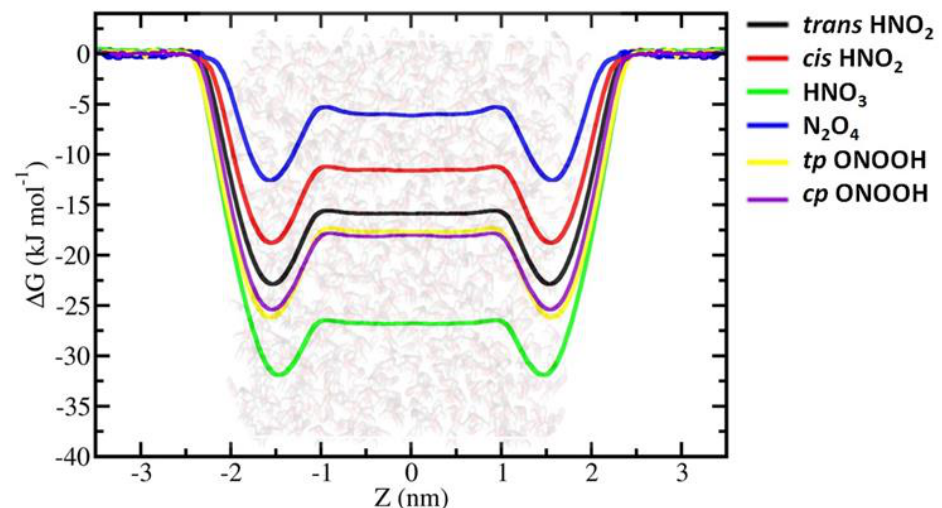
Figure 3. FEPs of the hydrophilic RNS obtained by US simulations by calculation of the WHAM method.